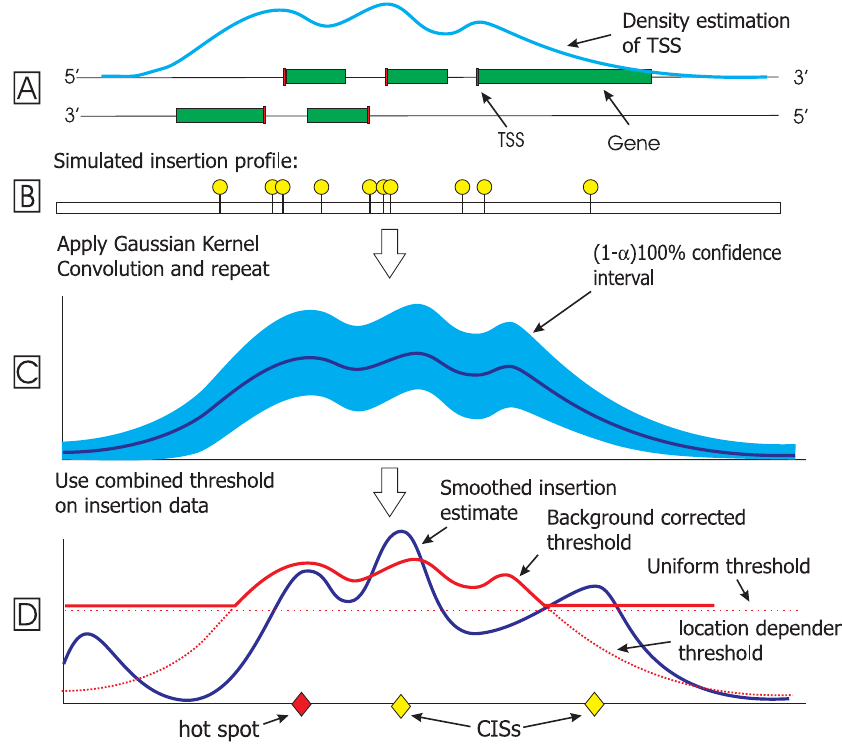
Figure 10. Schematic Depiction of the Computation of a Background-Corrected Threshold (A) The density of TSSs (the 5 9 ends of the genes) is computed using a fixed kernel width h bg . (B) A new realization of insertions is generated using the density from step A. (C) The GKC method is applied to the resulting insertion profile, yielding one realization of the background density estimate. Steps (A) and (B) and applying the GKC are repeated N times to yield a distribution of background realizations. For every position on the genome, a CDF of these realizations is computed and the threshold is determined based on the a -level. (D) The location-dependent threshold is combined with the threshold based on uniform background. Finally, the smoothed insertion estimate of the real data is thresholded with the resulting threshold.